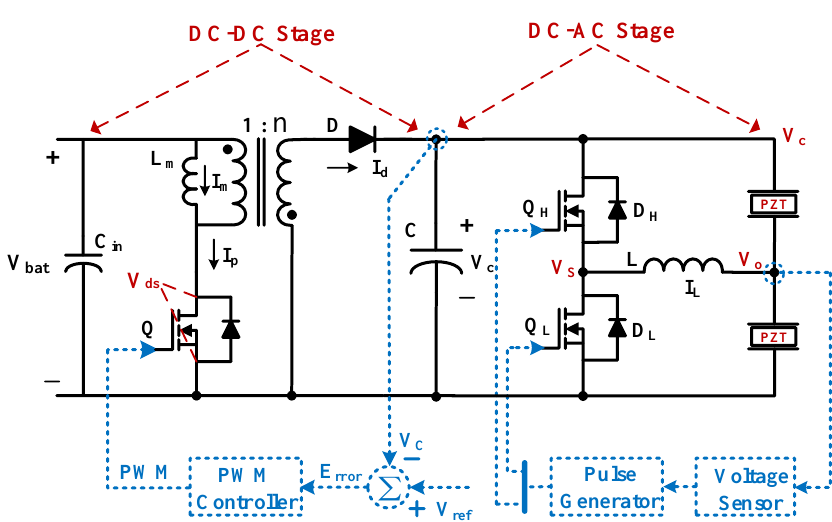
Figure 4. Bidirectional converter topology and control architecture.